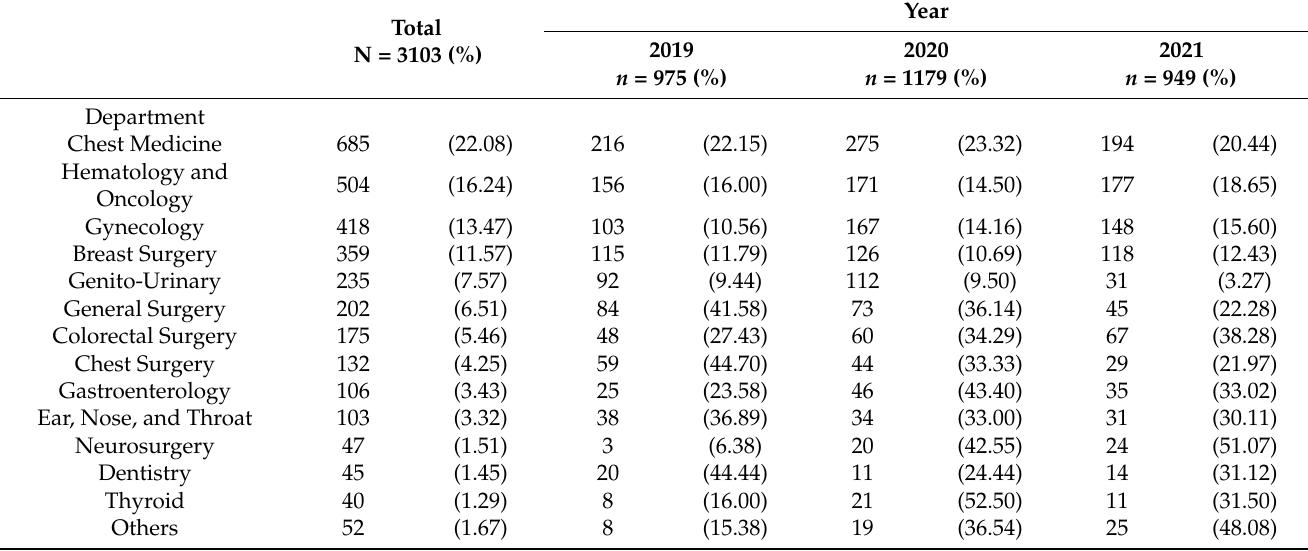
Table 2. Distribution of cancer inpatients by